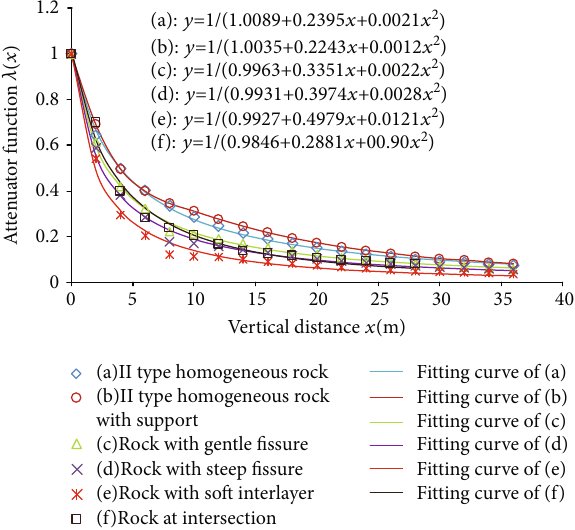
Figure 9: The attenuation function λ ð x Þ of the vertical spatial response of unloading